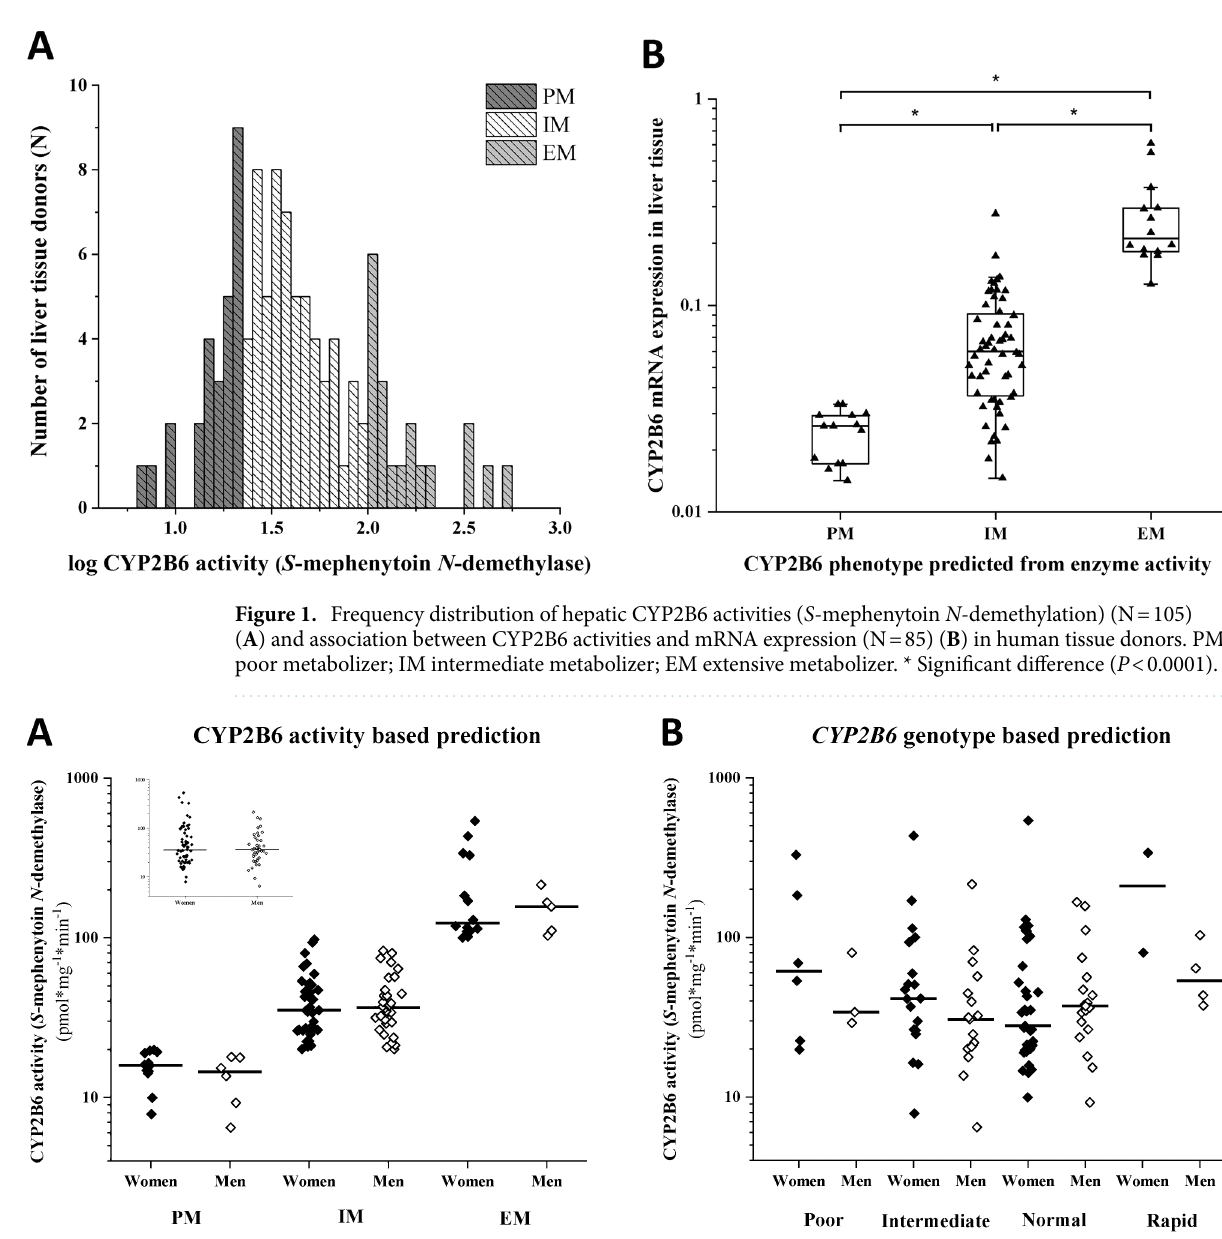
Figure 2. Gender-based differences in S -mephenytoin N -demethylation between various CYP2B6 metabolizer groups ( A ) and between CYP2B6 genotype groups ( B ). The inserted graph ( A ) displays the differences in CYP2B6 activities between men and